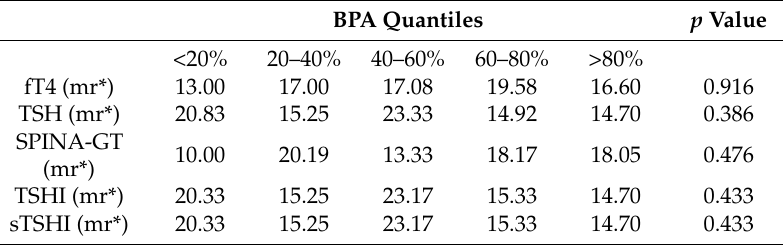
Table 3. Results of girls according to BPA quantiles.